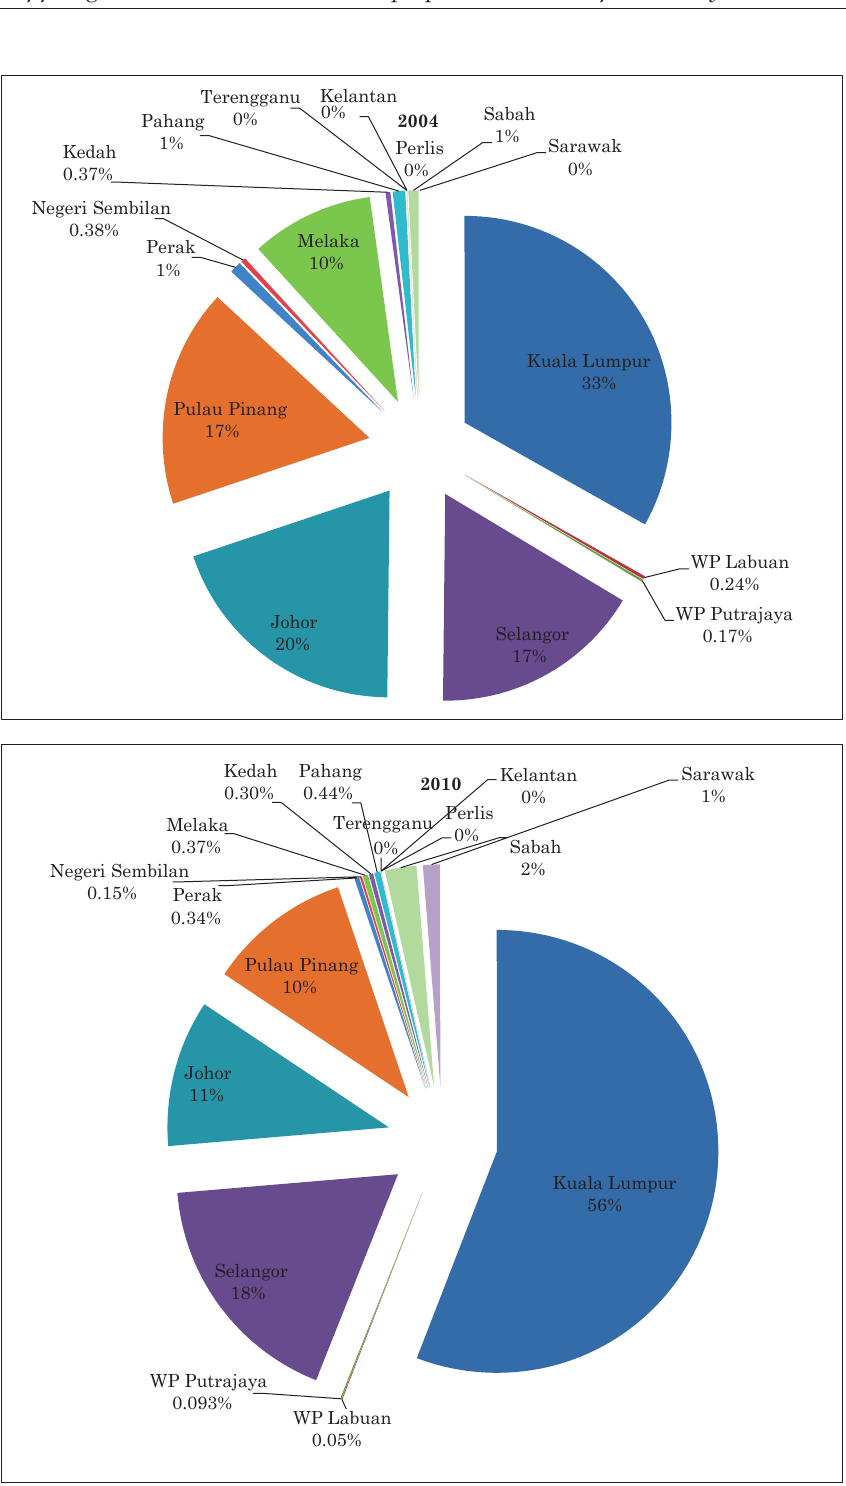
Figure 2. Locational distribution of FIRP (above 2004; bottom